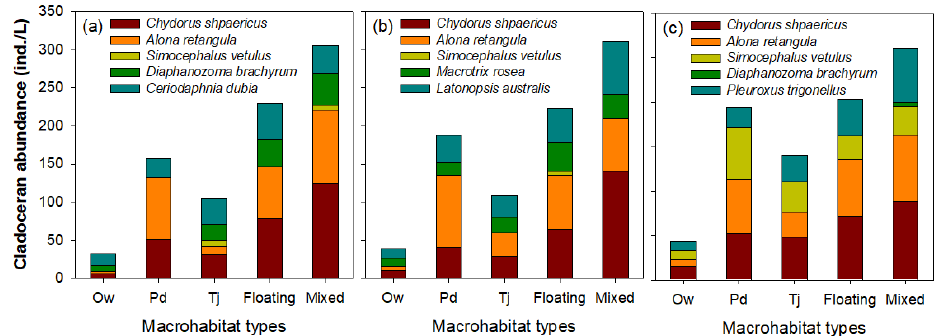
Figure 4. Abundance of dominant cladoceran species according to five microhabitat types. Ow: open water; Pd: the area covered by Paspalum distichum ; Tj: the area covered by Trapa japonica ; Floating: the area covered by floating-leaved macrophytes ( Hydrocharis dubia and Salvinia natans ); Mixed: the area covered by floating-leaved and submerged macrophytes ( Hydrocharis dubia , Salvinia natans , Ceratophyllum demersum , Hydrilla verticillata , and Najas graminea ). Chydorus shpaericus and Alona retangula are epiphytic cladocerans species, and the remaining three species ( Simocephalus vetulus , Diaphanozoma brachyrum , and Latonopsis australis ) are pelagic. ( a ) Upo Wetland, ( b ) Jangcheok Wetland, and ( c ) Beongae Wetland.